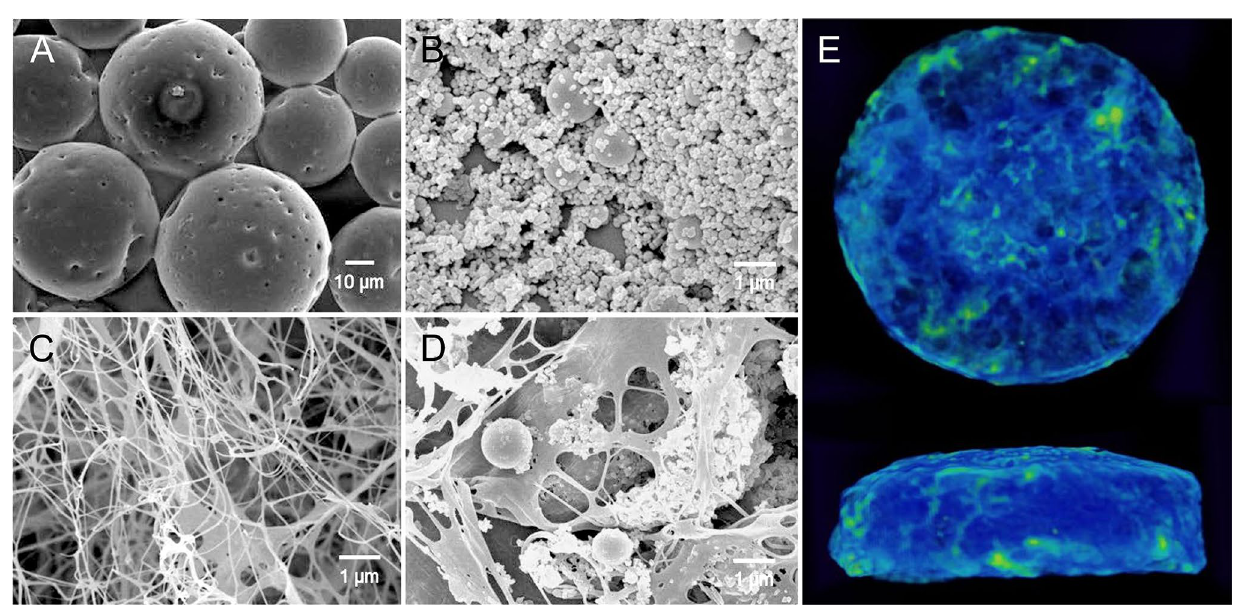
Figure 2. Morphological analysis of CHAS. SEM images of ( A ) PLGA microspheres; ( B ) hydroxyapatite; ( C ) collagen scaffold; ( D ) CHAS; ( E ) µ-CT images of CHAS (green threshold level at